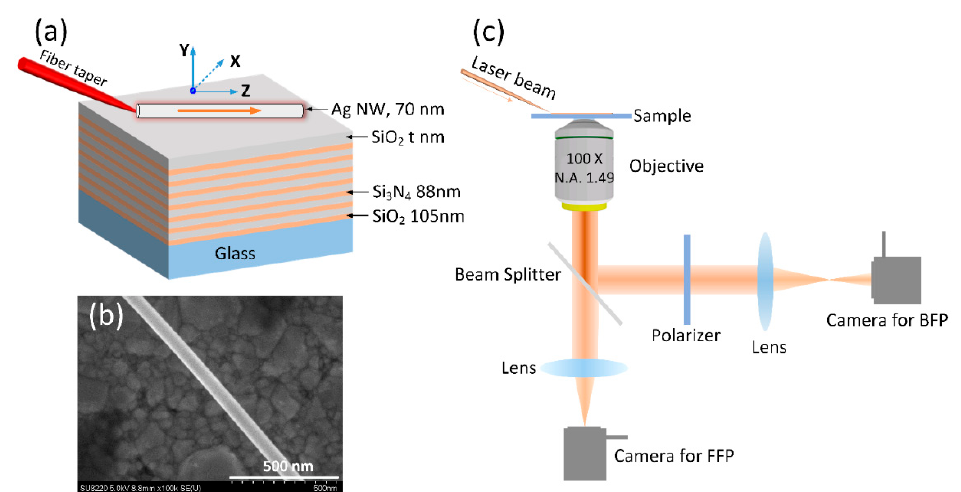
Figure 1. Schematic illustration of the sample. ( a ) The silver nanowire (Ag NW) was placed on a dielectric multilayer consisting of alternating layers of SiO 2 (105-nm-thick) and Si 3 N 4 (88-nm-thick). There were fourteen layers in total, with a top SiO 2 layer with a varied thickness of t nm. A fibre taper was used to couple the laser beam into the nanowire. The NW was oriented along the Z -axis and perpendicular to the X -axis; ( b ) SEM image of the Ag NW (diameter of 70 nm); ( c ) Schematic of the experimental set-up for imaging the plasmon’s propagation along the Ag NW. Two cameras are used for capturing the front focal plane (FFP) and back focal plane (BFP) images. A polarizer can be used to check the polarization state of this plasmonic mode.